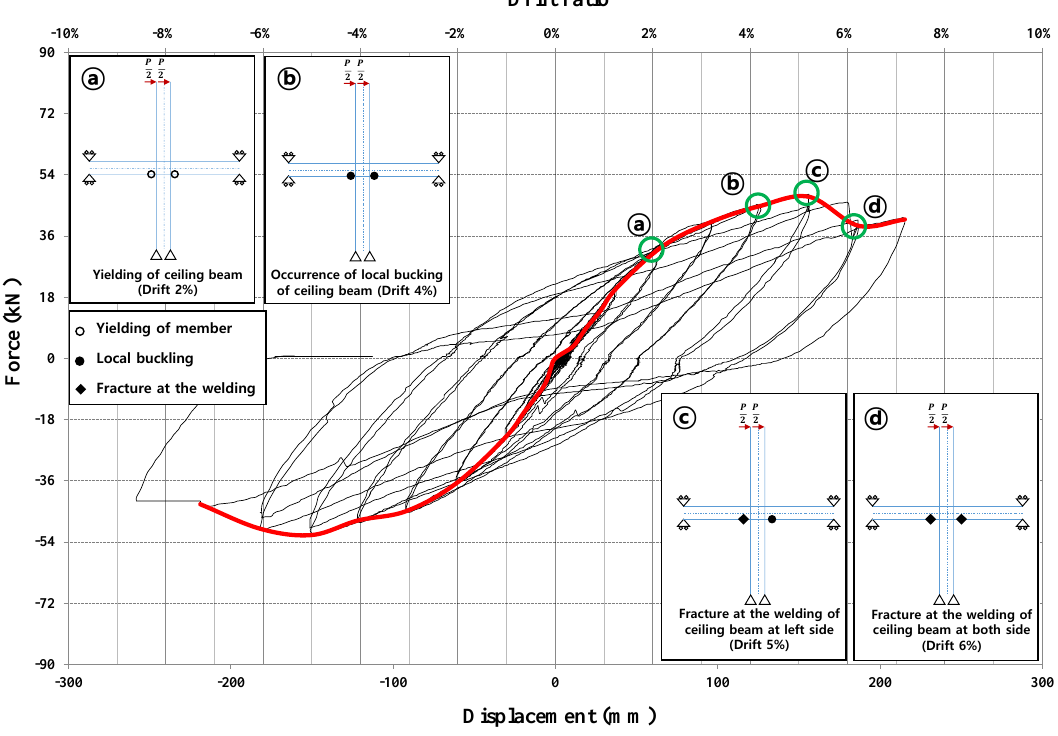
Figure 11. Hysteresis and backbone curves of specimen IC_OB_F.